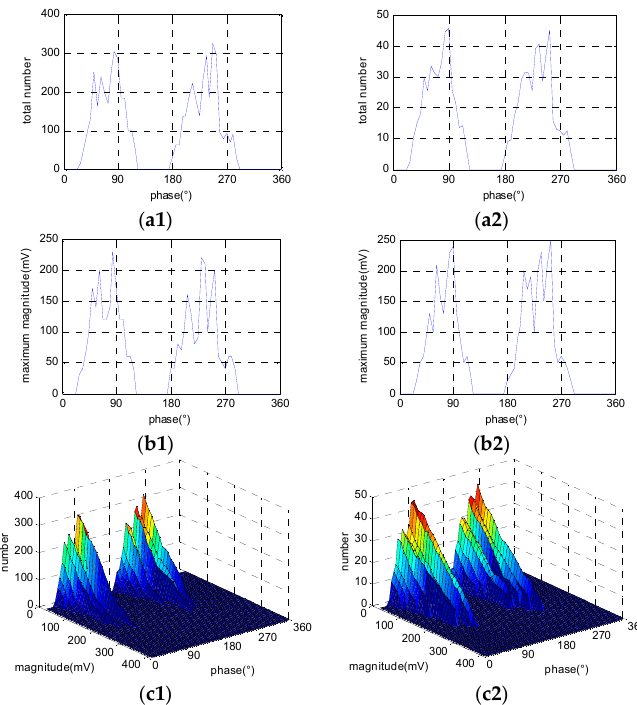
Figure 8. PD pattern charts of the surface discharge model. ( a1 )–( c1 ) are the φ ‐ n tot , φ ‐ V max , and φ ‐ V ‐ n pattern charts of data acquired by the intelligent sensor, respectively; ( a2 )–( c2 ) are the φ ‐ n tot , φ ‐ V max , and φ ‐ V ‐ n pattern charts of data acquired by the oscilloscope, respectively.